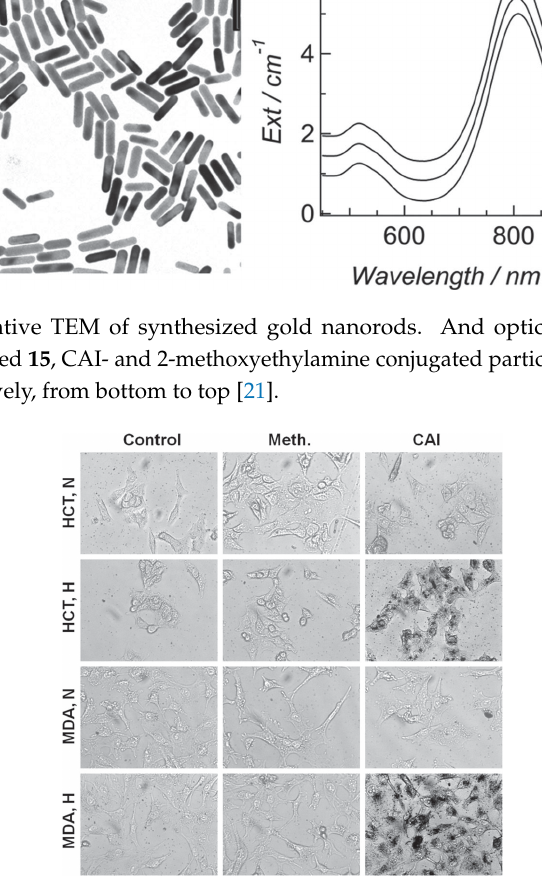
Figure 4. 470 μm × 400 μm Optical micrographs of HCT cells treated with 100 μM Au particles 16, 17 with different terminations and under hypoxia (H) or normoxia (N), and then excited with light at 810 nm and different power density for 5 min. After fixation, cells were stained with trypan blue [21].